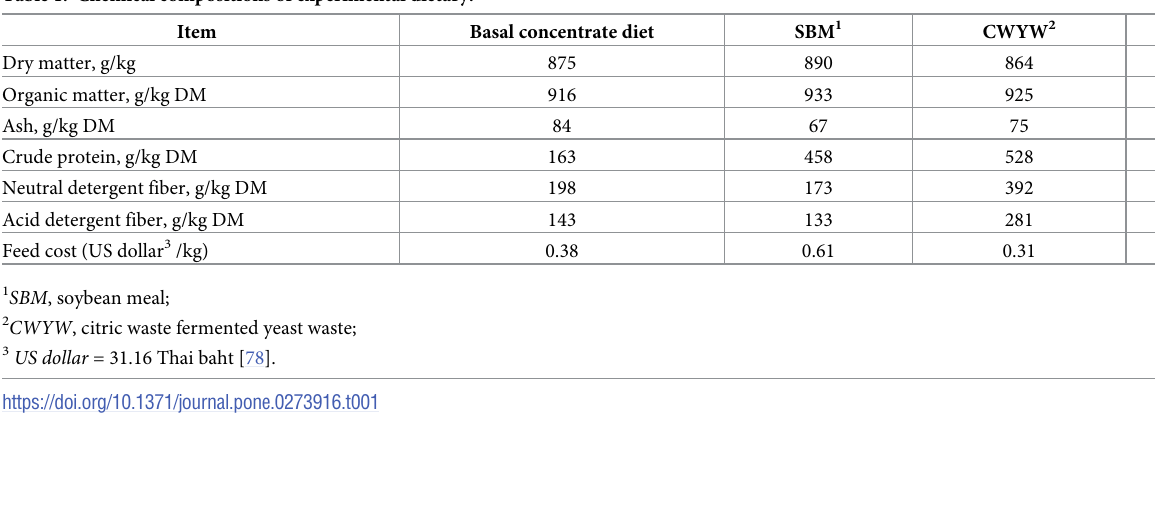
Table 1. Chemical compositions of experimental